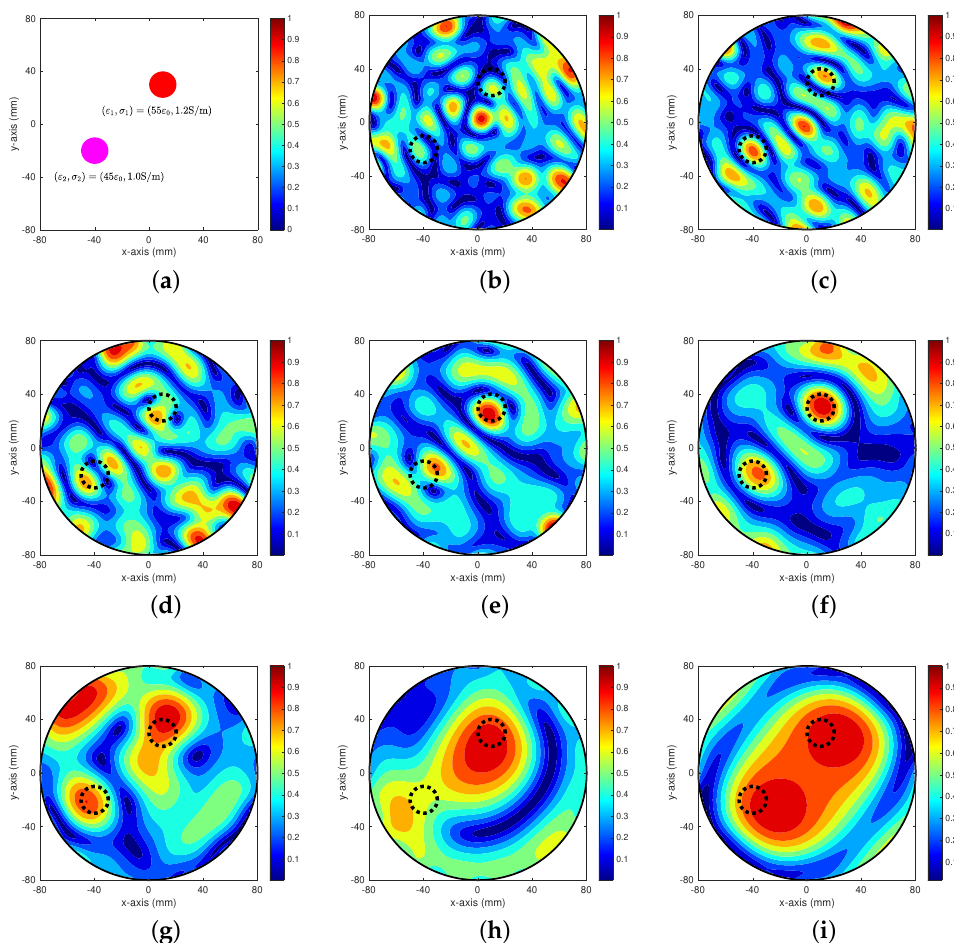
Figure 4. (Example 2) Maps of F BS ( r , n ) . Black-colored dashed lines describe the boundaries of ob- jectives. ( a ) Small objective, ( b ) n = 1, ( c ) n = 2, ( d ) n = 3, ( e ) n = 4, ( f ) n = 5, ( g ) n = 6, ( h ) n = 7, ( i ) n =